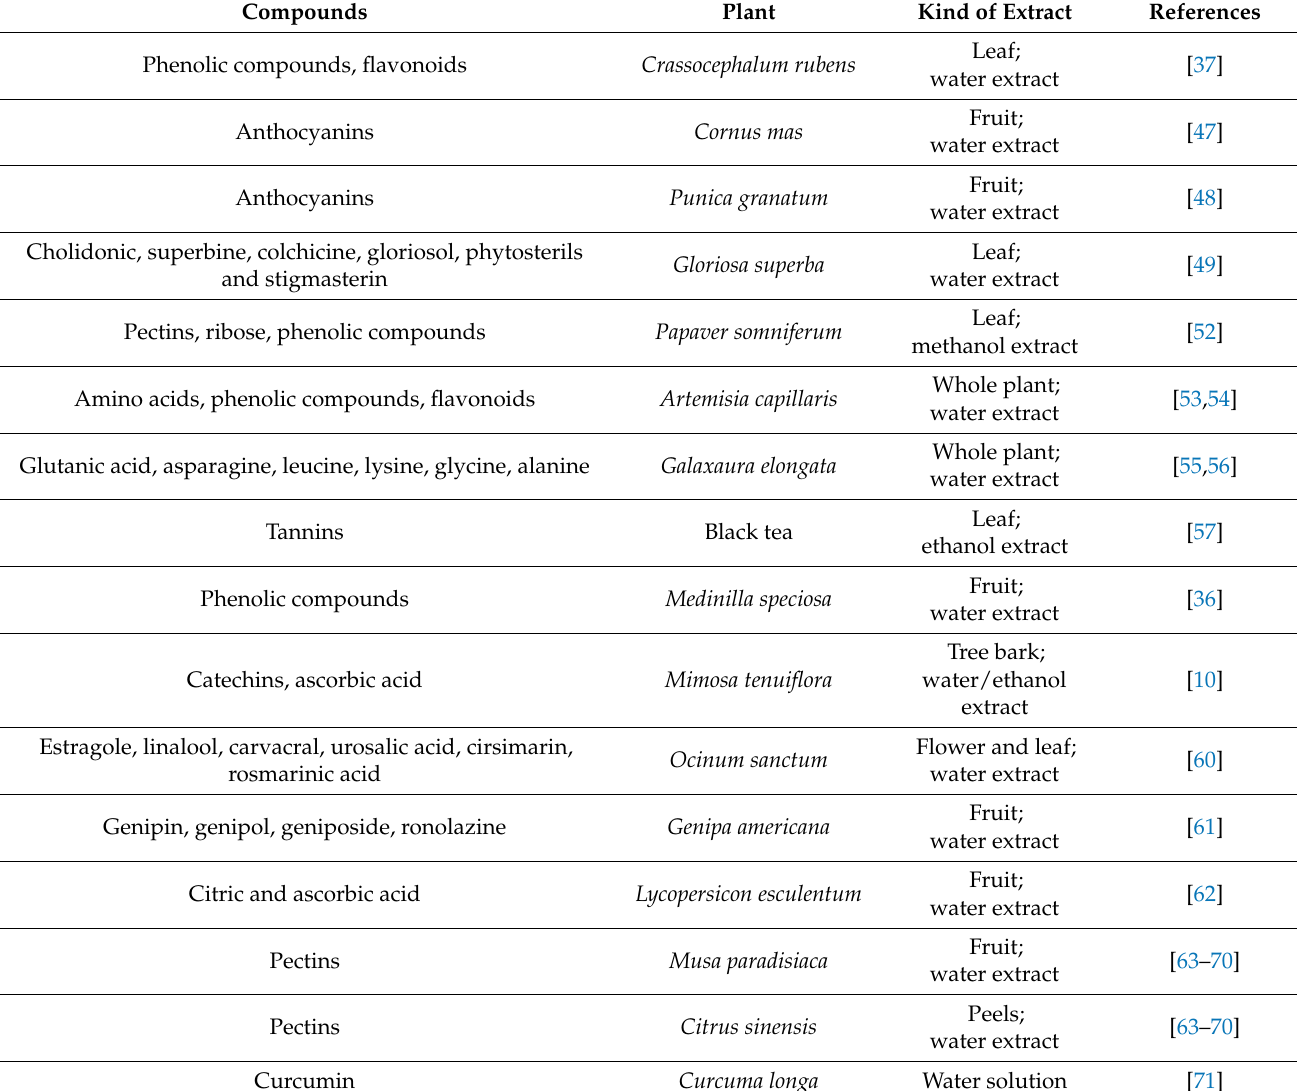
Table 1. Compounds responsible for creating the reducing potential of plant